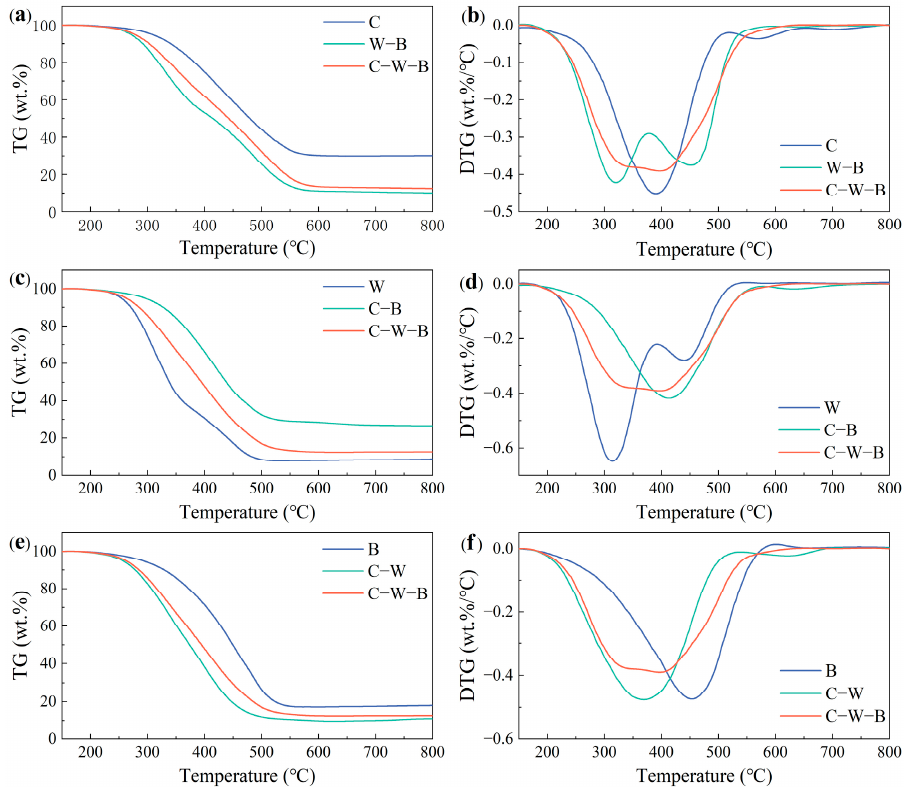
Figure 5. Impact of the third material addition on the binary blends at a heating rate of 10 °C/min: ( a, b ) coal as the third material; ( c, d ) walnut shell as the third material; ( e, f ) biochar as the third